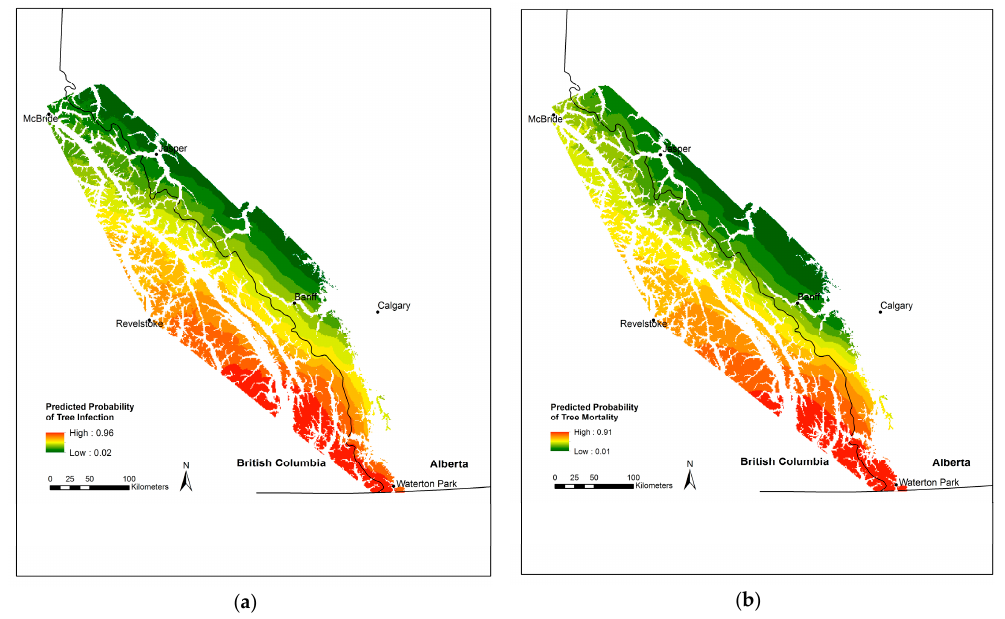
Figure 4. Predicted probability of blister rust infection for a 10 cm DBH tree ( a ) and predicted probability of mortality ( b ). Maps are based on predictions for 2014 using quantile classification with 10 bins of predictions for trees nested in plots. Areas below 1579 m were clipped from the map consistent with our lowest elevation study plots.